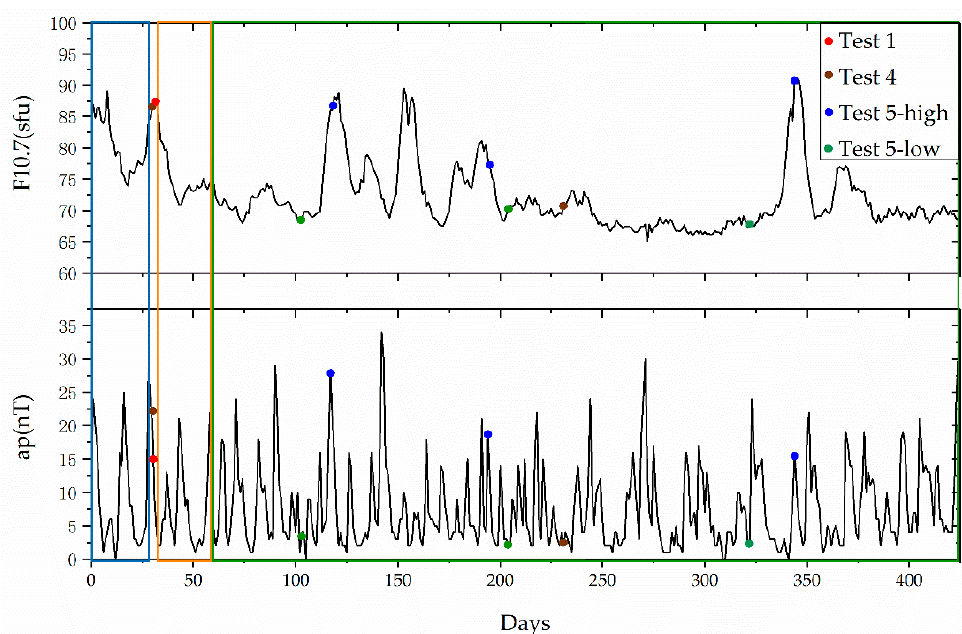
8 of 21 Table 1. The mean of solar radio flux (F10.7) and geomagnetic index (ap) in different time span. Texst Time Span